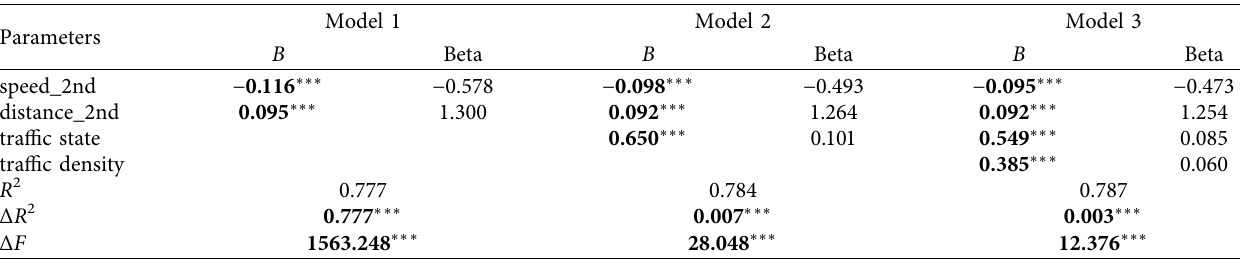
Table 7: Regression analysis results of the braking duration.